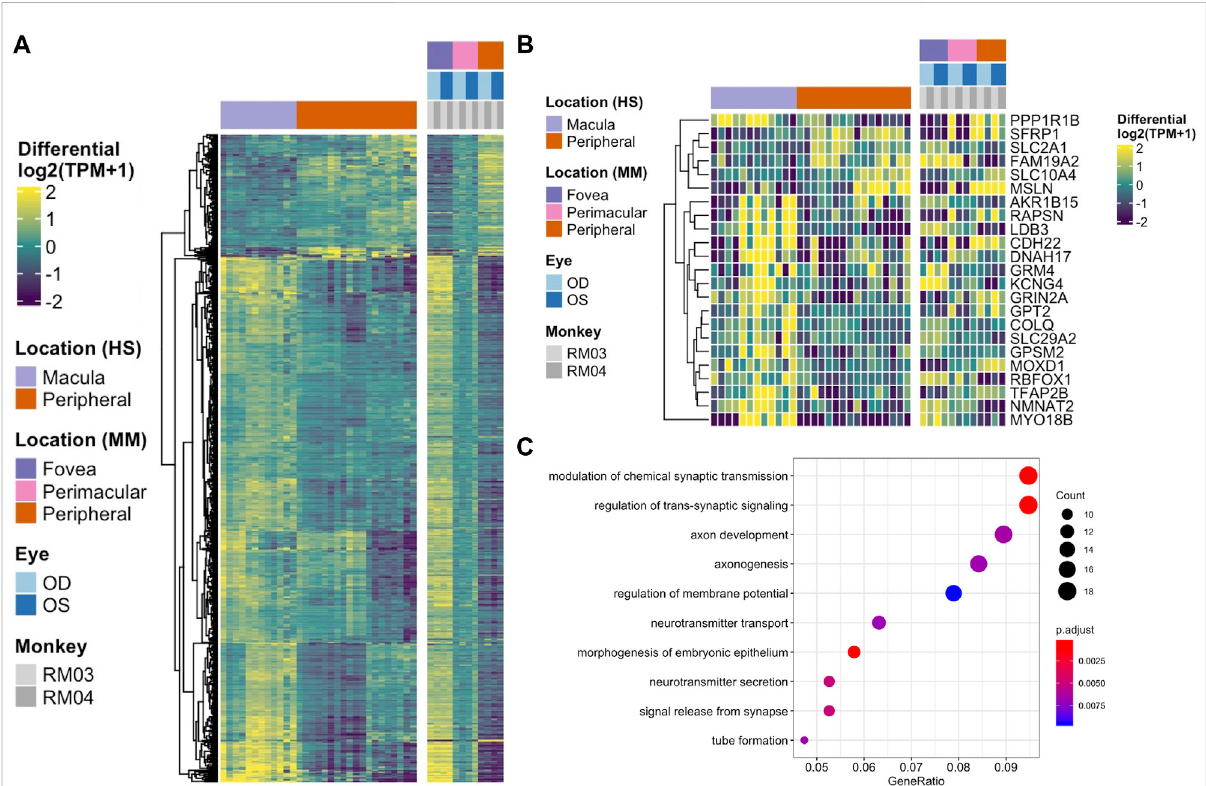
FIGURE 3 (A) Heatmap displaying the comparison of differential gene expression in the neural retina between published data from a human macula vs. periphery set(Lietal.,2014;Whitmoreetal.,2014)andthemacaquedatapresented here,with664genesfollowingsimilarexpressionpatterns. (B) A comparison of conserved differential expression to the human studies in the RPE/choroid tissue. Fewer genes follow similar patterns of differential expression. (C) GO enrichment for conserved differentially expressed genes between human and macaque datasets in the neural retina. Terms including neuronal connectivity and cellular morphogenesis are highly